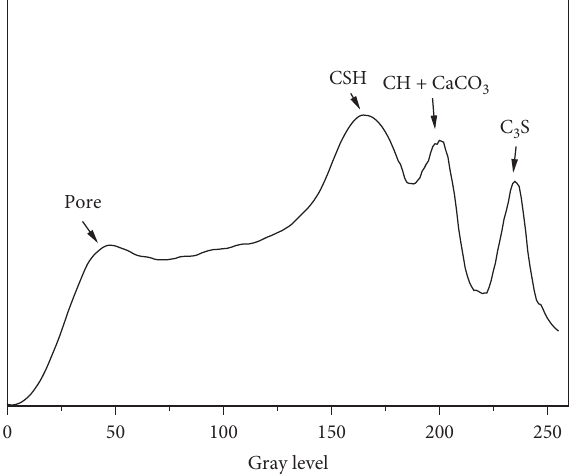
Figure 11: Gray distribution of BSE images of the BSE